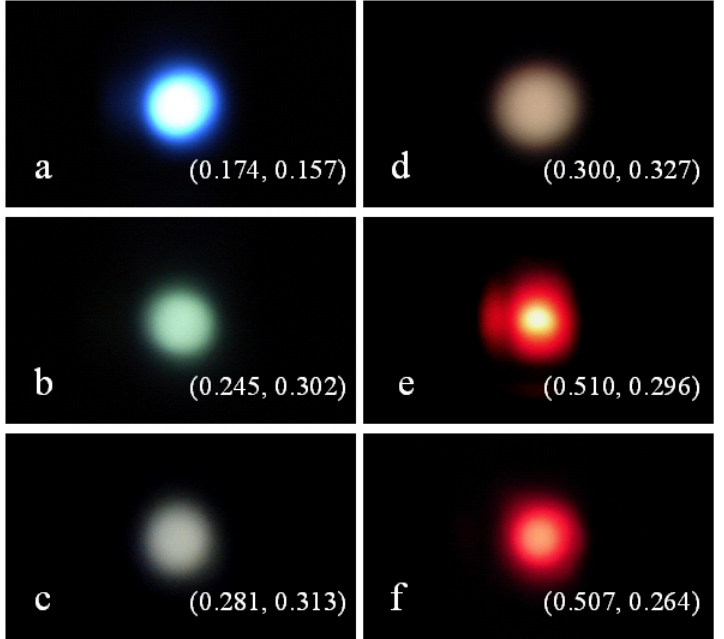
Figure 6. Photographs of the PL from SrAl 2 O 4 :Dy 3+ before Mn 4+ diffusion ( a ) and after Mn 4+ diffusion at temperatures of 600 °C ( b ), 700 °C ( c ), 800 °C ( d ), 900 °C ( e ), and 1000 °C ( f ). The diffusion time is 4 h.